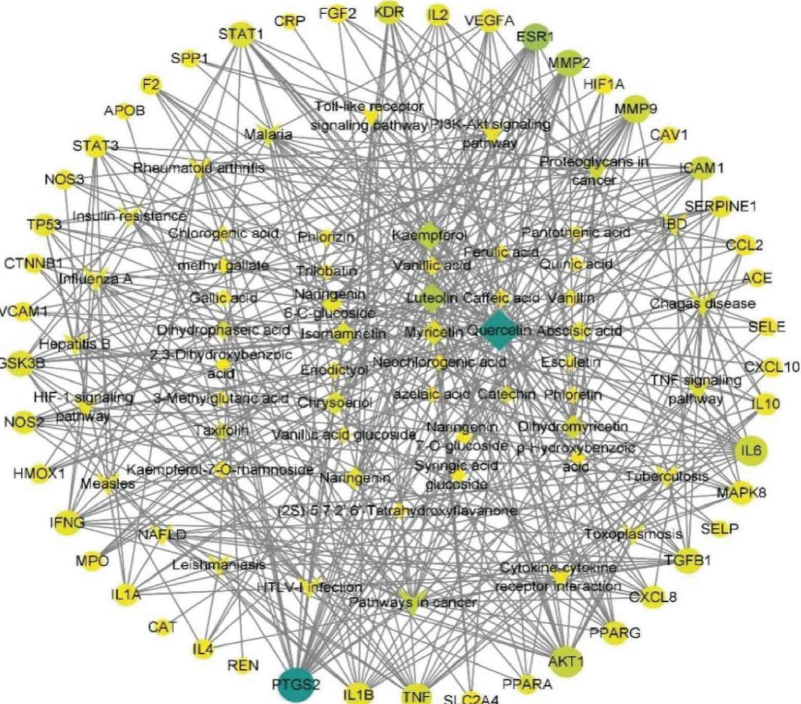
Figure 6: Te active component-keygene-pathway interaction network. As the betweenness centrality increases, the color of the node changes from yellow to turquoise, and the larger the node, the greater the degree